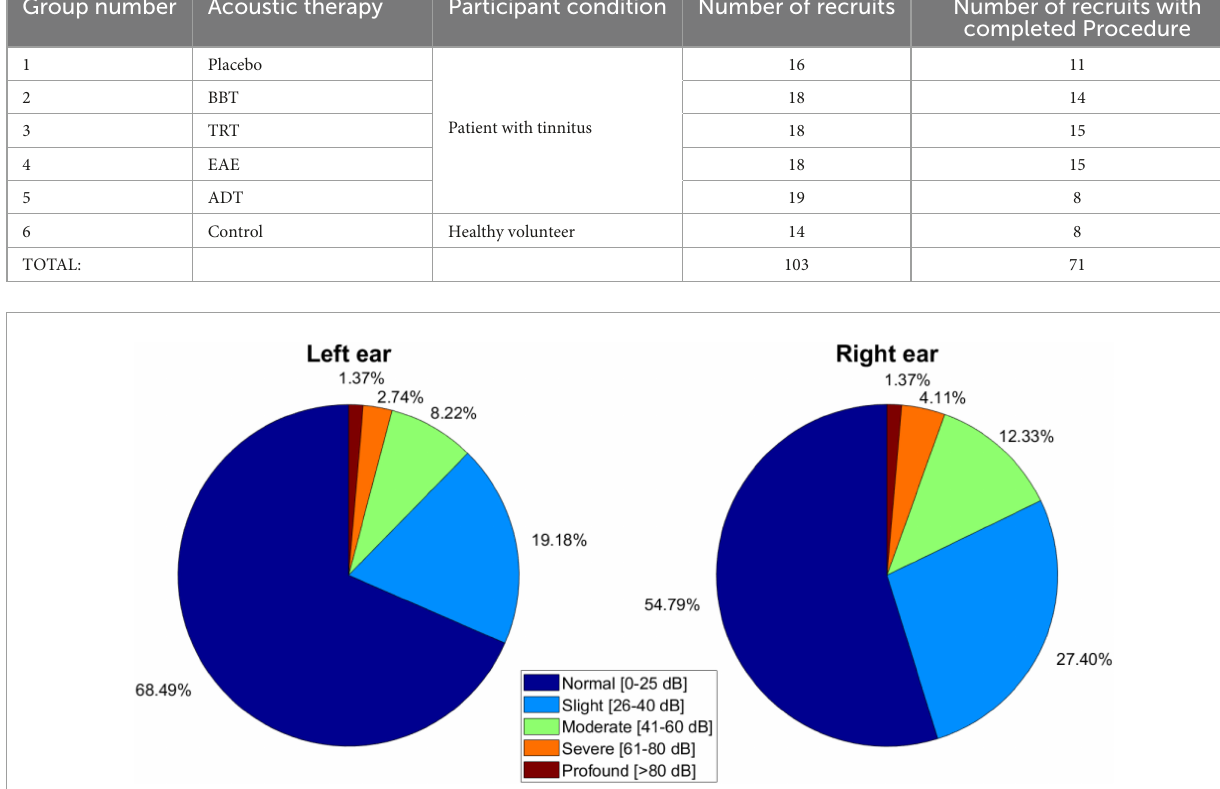
FIGURE2 Hearing levels of the cohort of 71 tinnitus sufferers presented in five levels: (1) Normal hearing (0–25 dB), (2) slight (26–40 dB), (3) moderate (41–60 dB), (4) severe (61–80 dB), or (5) profound ( > 80 dB) hearing loss.